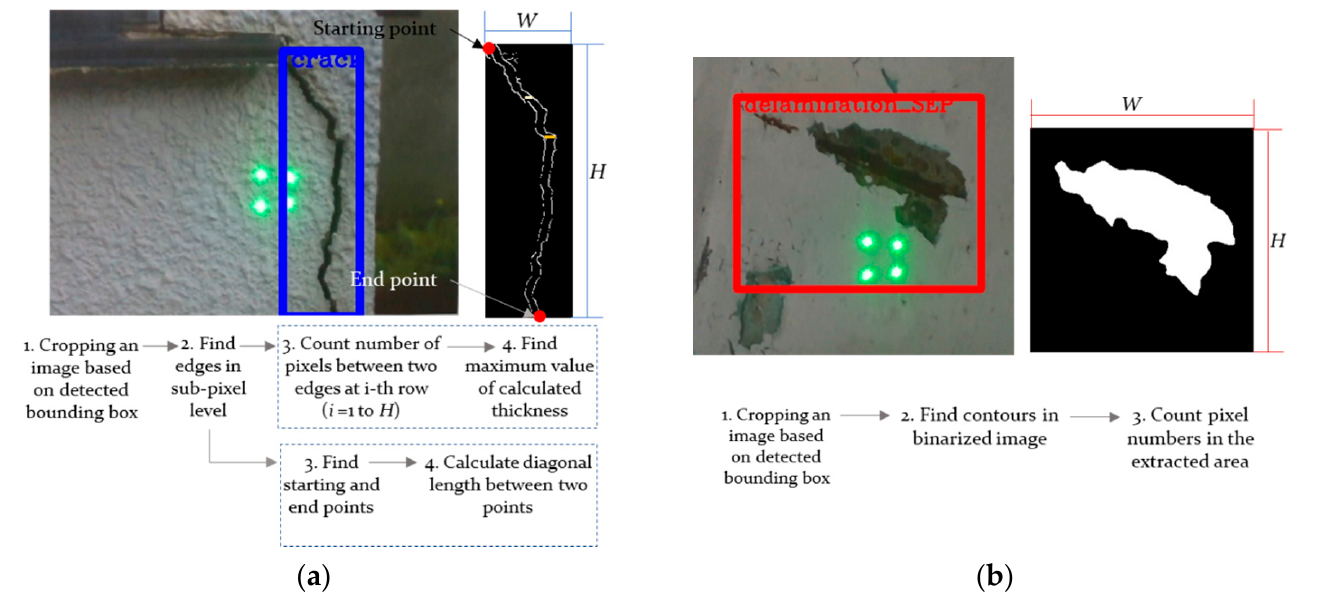
Figure 3. Image processing for quantification of: ( a ) cracks; and ( b ) delamination and rebar exposure.